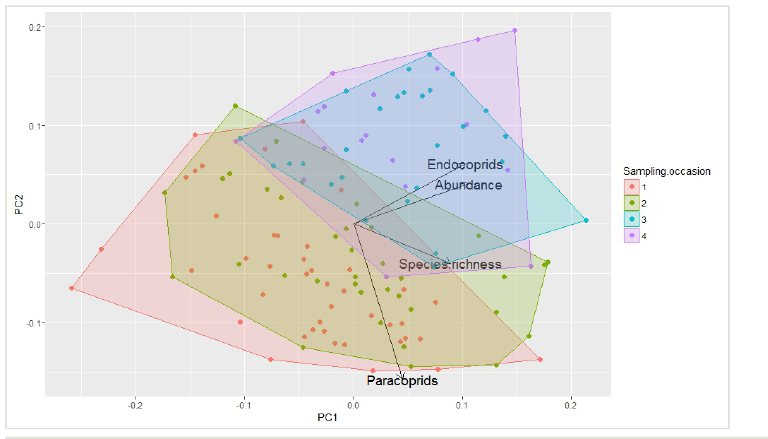
Scatterplots of the fi rst two components scores obtained from the PCA of dung beetle diversity of Troncea B (percentages of the explained variance: PC1= 64%, PC2= 25%), of fi rst sampling occasion (red), second sampling occasion (green), third sampling occasion (light blue), and fourth sampling occasion